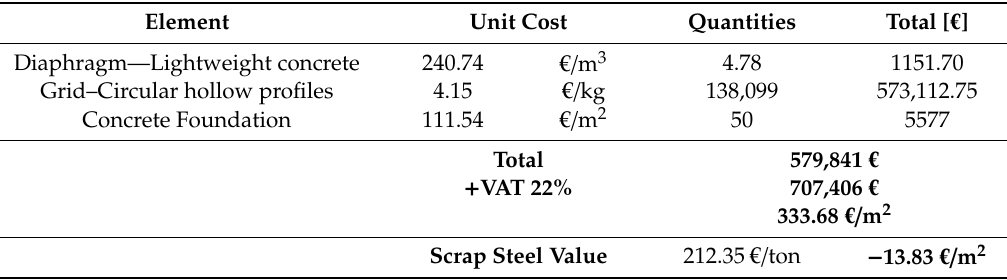
Table 6. Shear walls system cost analysis [42].